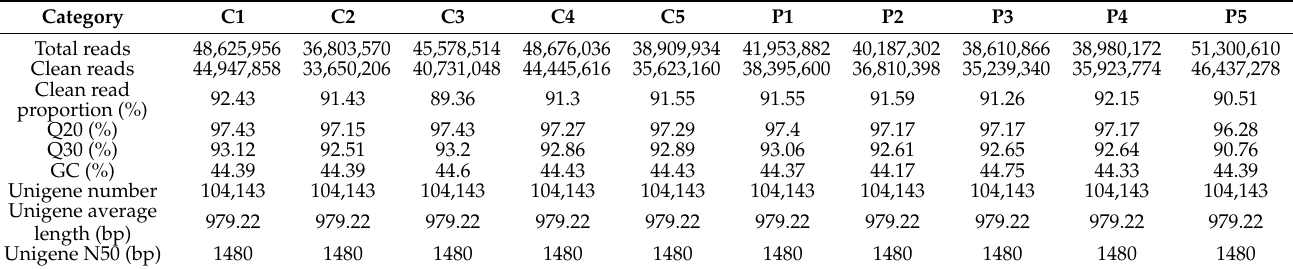
Table 1. Liver transcriptome sequencing analysis.